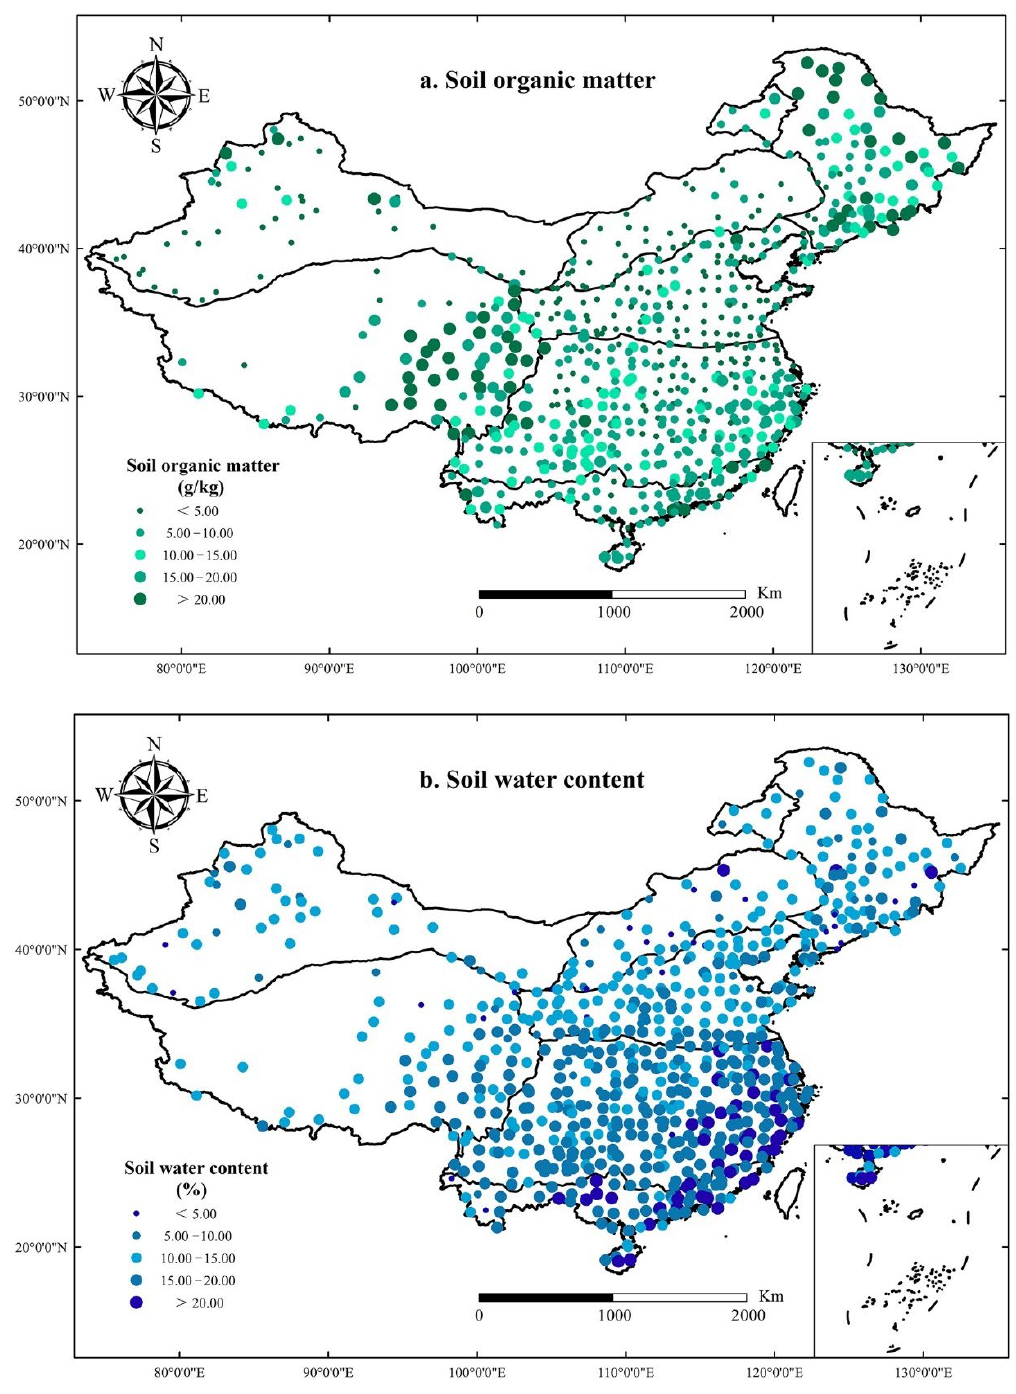
Figure 7. Spatial distribution of soil organic matter content ( a ) and soil water content ( b ).